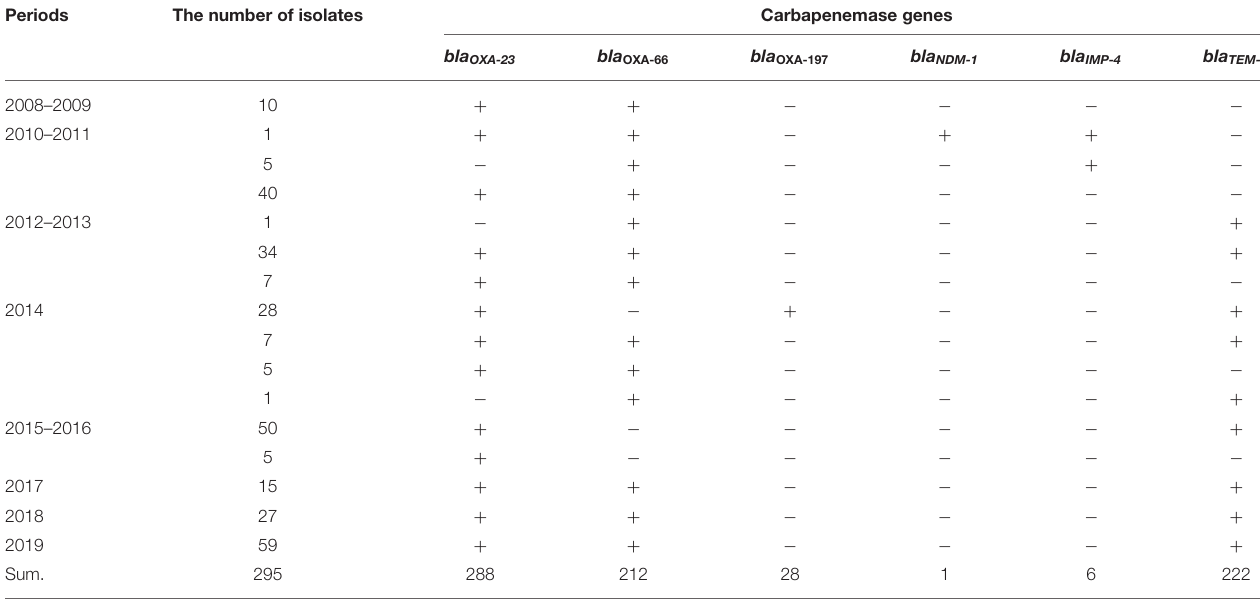
TABLE 4 | The profiles of the carbapenemase genes of 295 MDR A. baumannii isolates. Periods